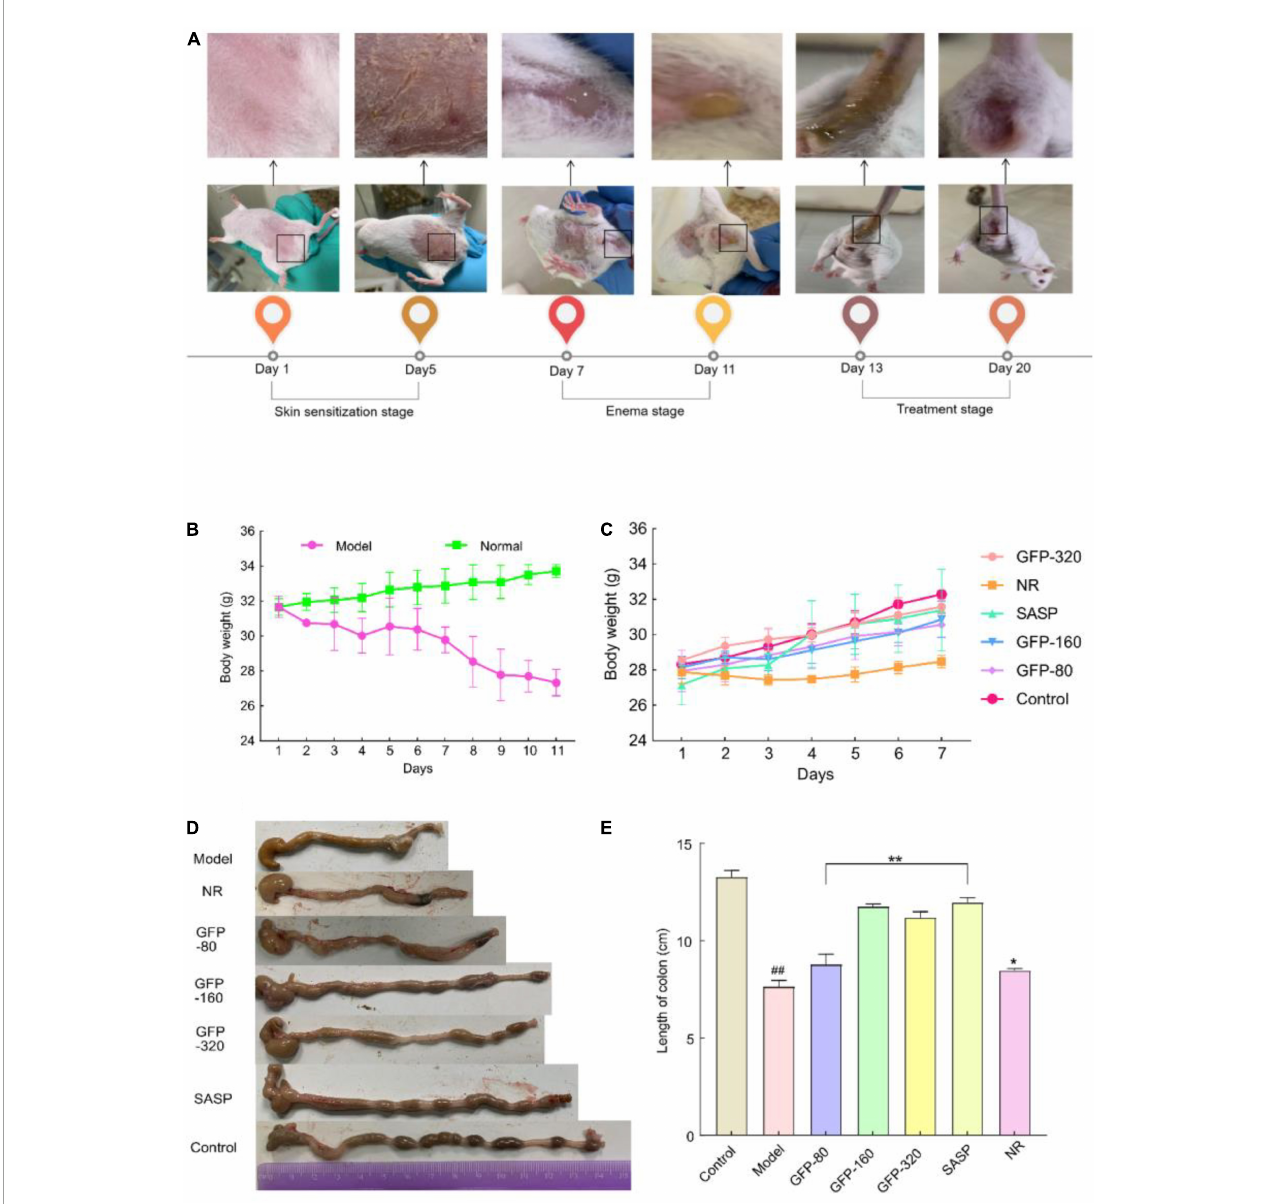
FIGURE6 Changes in body weight and colon length of mice in each group. (A) Apparent changes in mice at different stages. (B,C) The body weight of mice at different stages. (D,E) Changes in the colonic length of mice at different stages. Each value represents the mean ± SD of six independent experiments. ## Very significant difference compared with the control group ( P < 0.001); *significant difference compared with the model group ( P < 0.05), **extremely significant difference compared with the model group ( P < 0.001), * or # no significant difference ( P > 0.05).